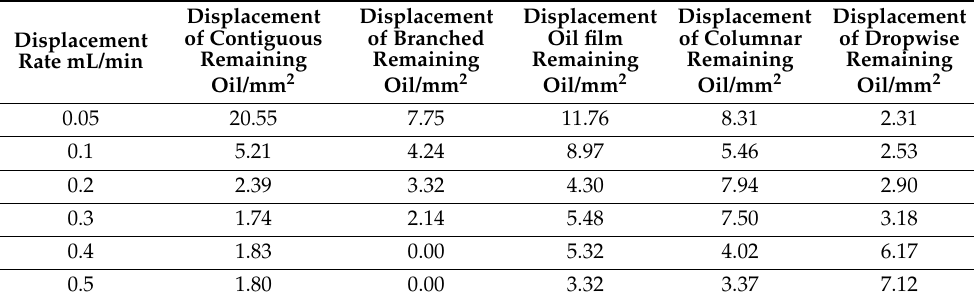
Table 4. Quantity of remaining oil produced in different displacement